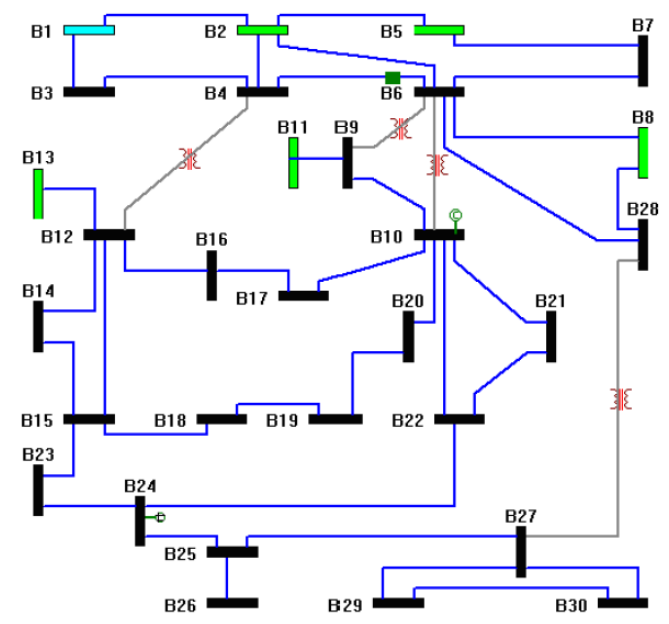
Figure 5. IEEE 30-bus system.